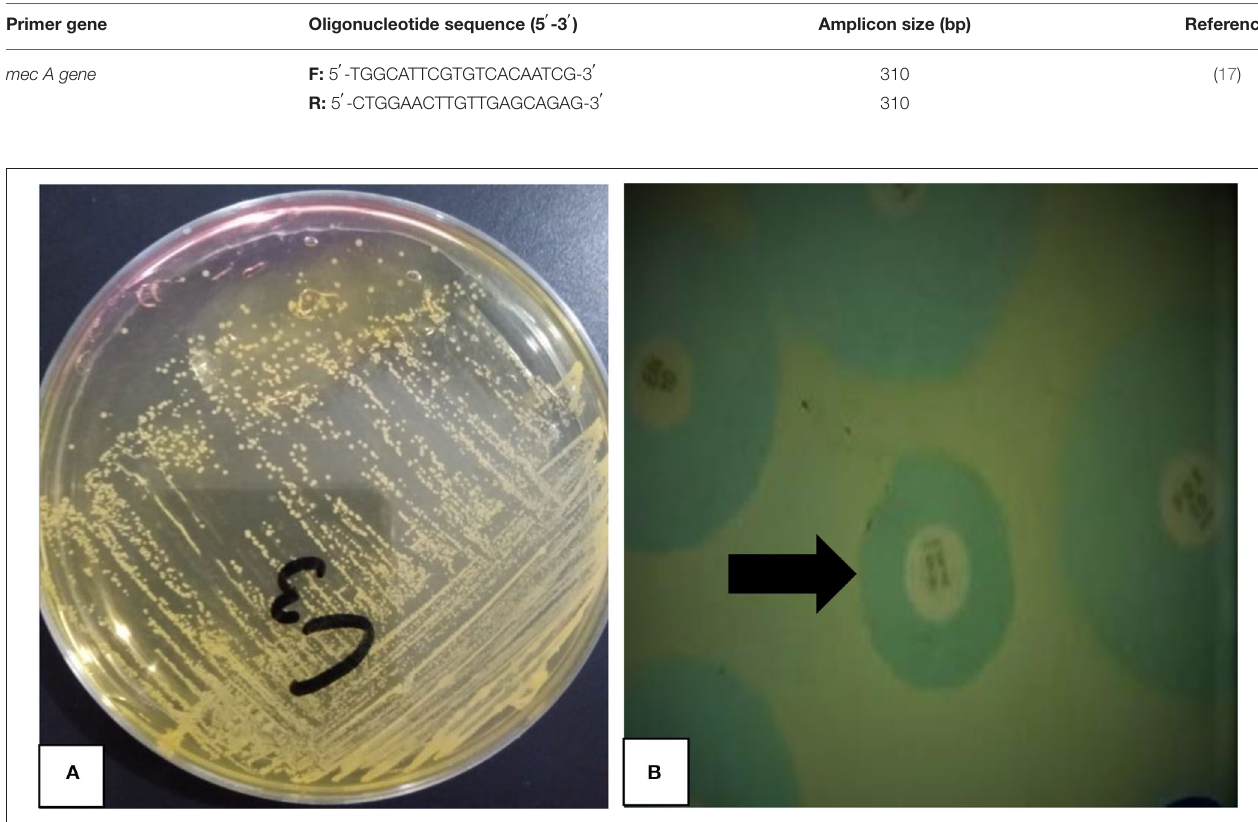
FIGURE 1 | Phenotypic identification of Staphylococcus aureus and methicillin-resistant S. aureus (MRSA). (A) A Yellow color growth of S. aureus (pinpoint colonies) on mannitol salt agar, NB: C3 mentioned on plate is sample number tested (B) methicillin resistant S. aureus (MRSA) identified by oxacillin disc (black arrow) diffusion